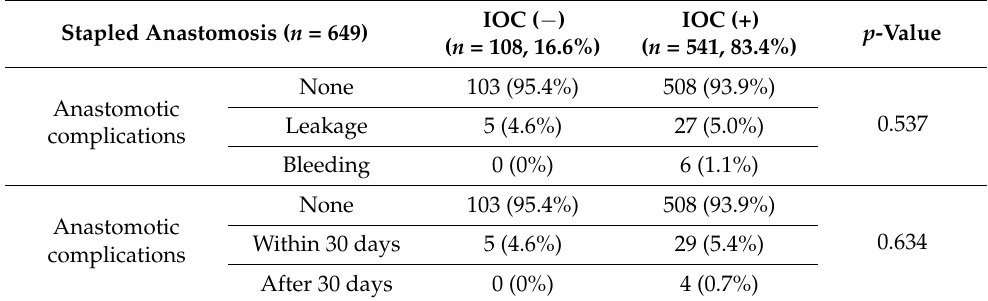
Table 3. Comparison of anastomotic complication rates based on the intraoperative colonoscopic